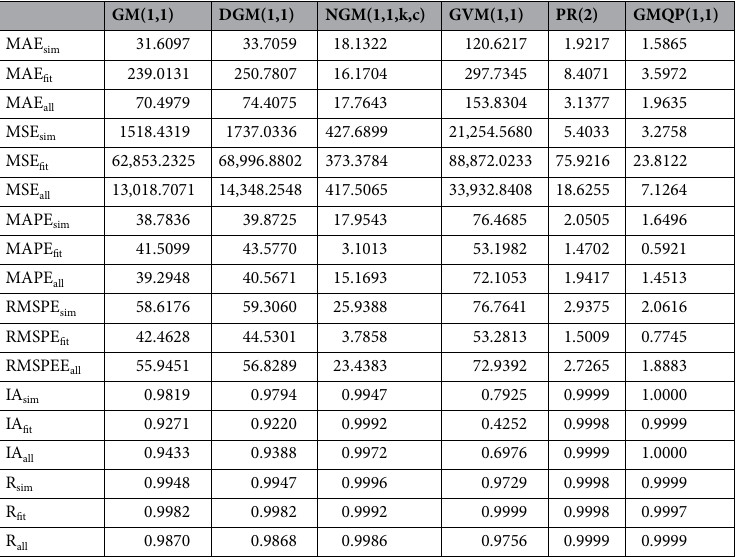
Table 14. The evaluation measures of different forecasting models in the death